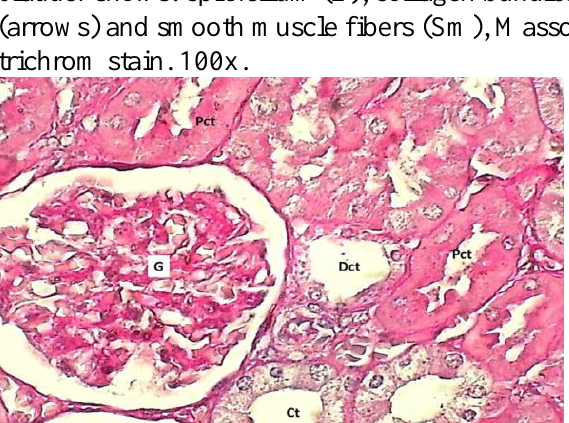
Figure, 12: Histological section of renal cortex shows: glomerulus (G), PAS positive reaction in proximal convoluted tubules (Pct), distal convoluted tubules (Dct) and colleting tubules (Ct). PAS stain. 400x.